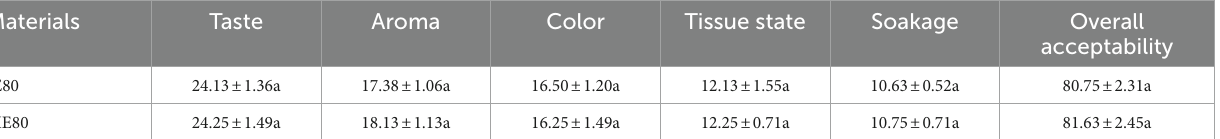
TABLE 4 Sensory evaluation parameters of different instant powder samples.